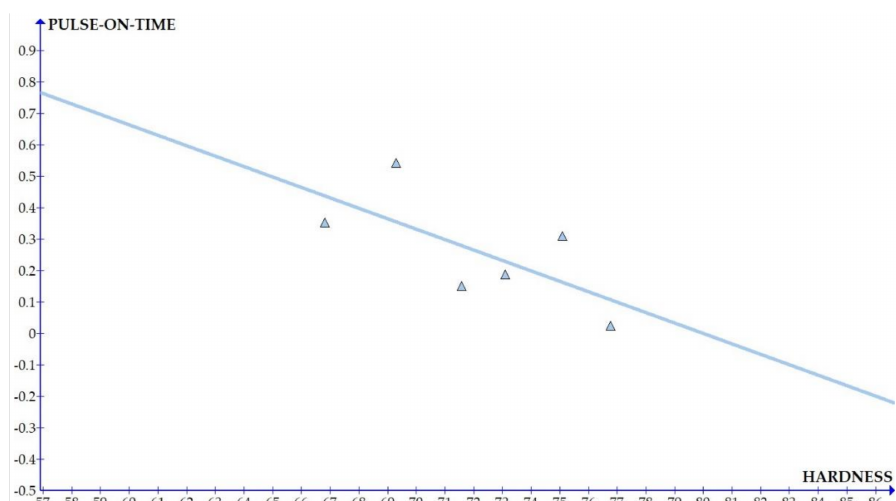
Figure 18. Coefficient of surface roughness: feed vs. hardness.